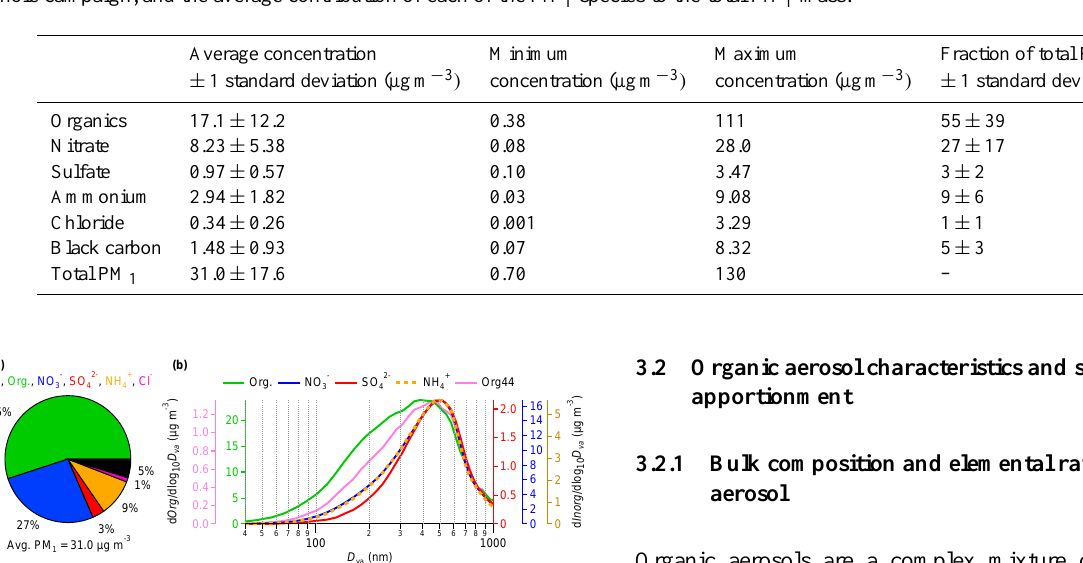
Table 1. Average ( ± 1 standard deviation), minimum and maximum concentrations of the PM 1 species and the total PM 1 mass over the whole campaign, and the average contribution of each of the PM 1 species to the total PM 1 mass.